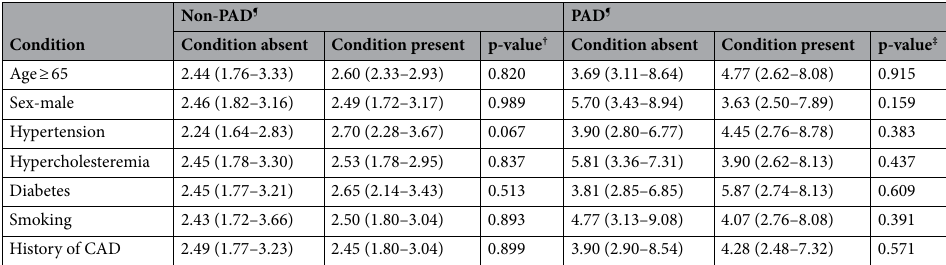
Table 2. Median values of uFABP3/uCr in PAD and non-PAD patients with and without various PAD risk factors and comorbidities. ¶ Median uFABP3/uCr, μg/g (interquartile range) for each subgroup. † Difference among non-PAD patients. ‡ Difference among PAD